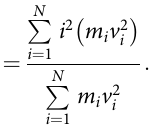
different disordered chains in Fig. 5. The red circles and error bars, respectively, give the mean values and standard deviations of the computed exponents from the 100 cases. The relevant trends persist despite the larger error bars for stronger precompressions.